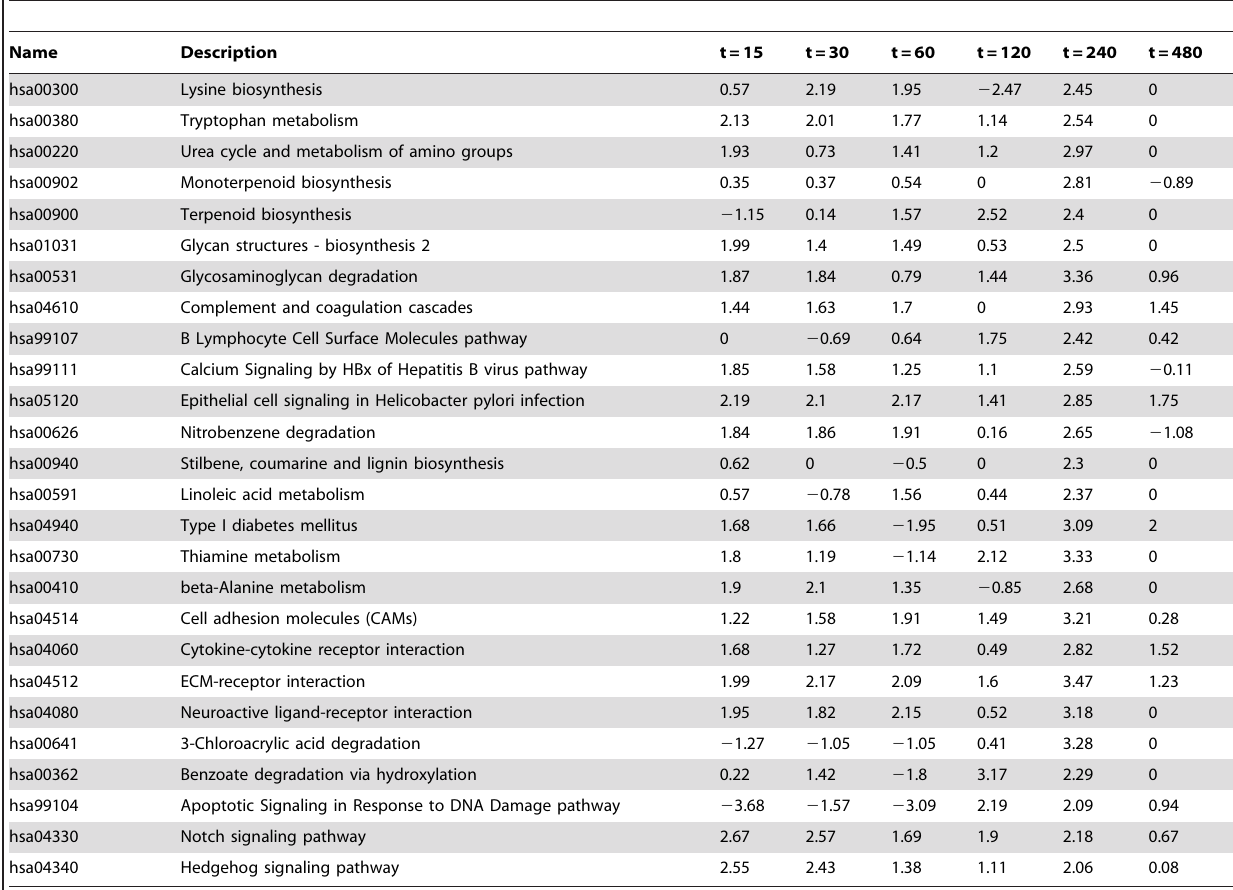
Table 6. Pathways that differed in regulation between early and late time points in WT vs MUT based on Bayesian z -score described in Table